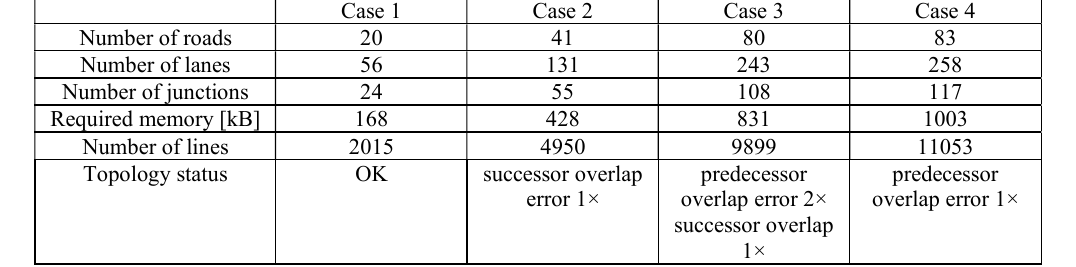
Table 8. Statistics for the samples (Number of lines are counted in the XML model)